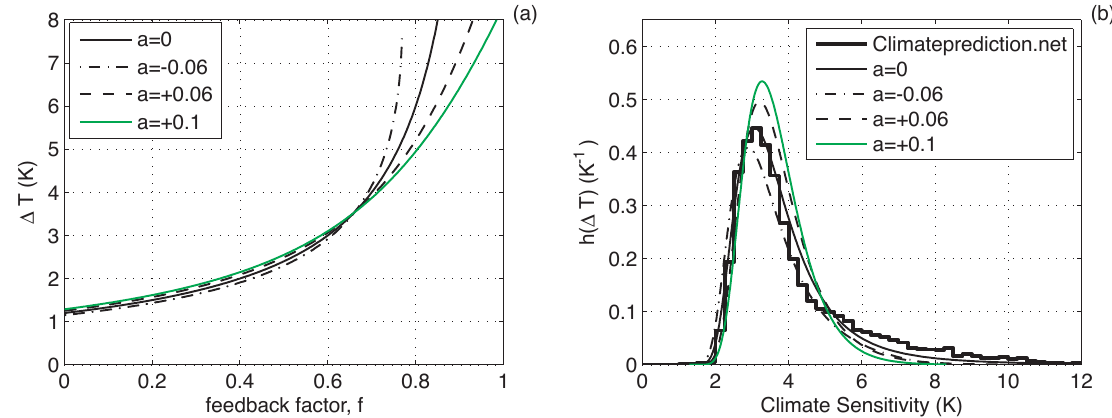
Fig. 1. (a) relationship between f and 1T for extreme range of a found in models. The curves all go through ( f , 1T ) = ( ∼ 0 . 65, ∼ 3.5 ◦ C), as they must in order to match published calculations of model feedbacks which have assumed the 1T − f relationship to be linear. That is: in cases for which a 6= 0 we adjust the true f so that a linear analysis would produce apparent values (0.65, 3.5 ◦ C). (b) The resulting pdfs of climate sensitivity for normal distributions in feedbacks (see RB), and the climateprediction.net results. Also shown are results for a = 0 . 1, the smallest value countenanced by ZG, who also consider a = 1 and a = 10.